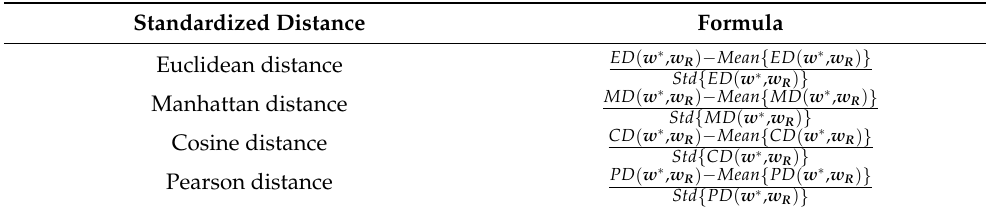
Table 2. Formulas for standardizing distance methods.